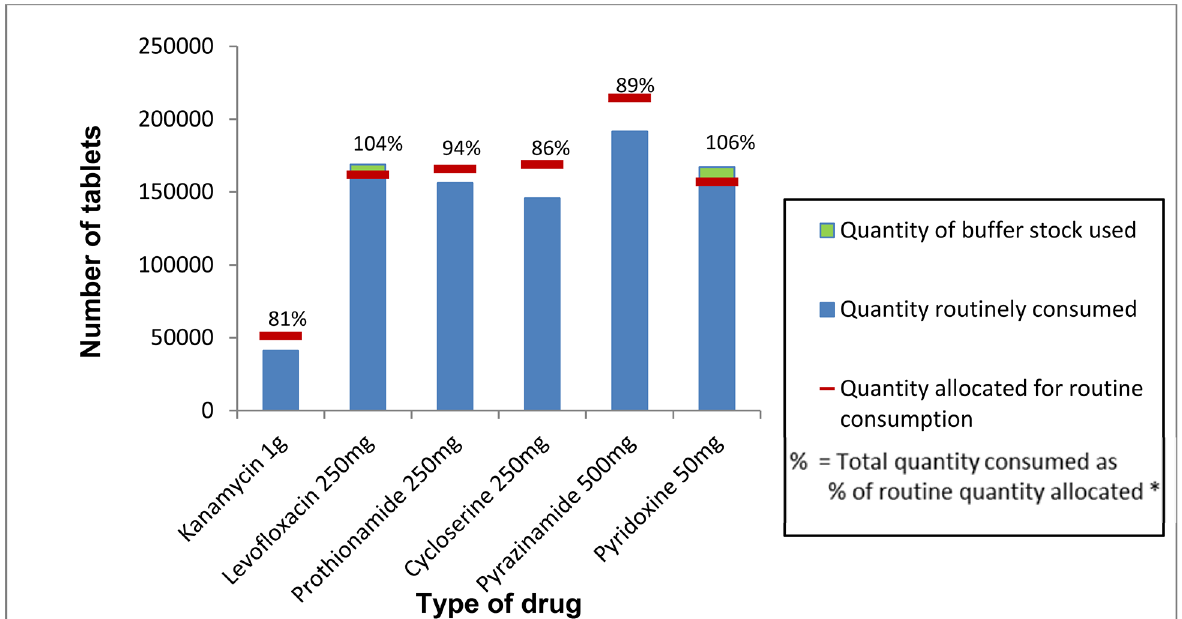
Fig 1. Proportion of drugs for multi-drug resistant tuberculosis consumed at the treatment centre level out of the total quantity allocated for routine consumption, Nigeria, 2013 (Target = 100%).